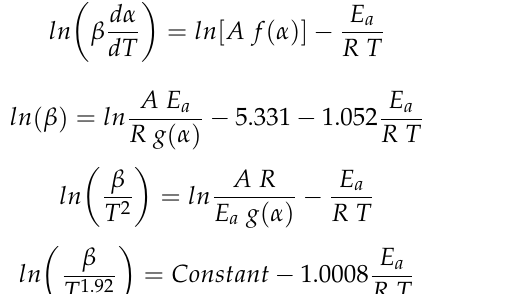
Table 3. Solid-state thermal reaction mechanisms. Reaction Mechanism Reaction-Order Models